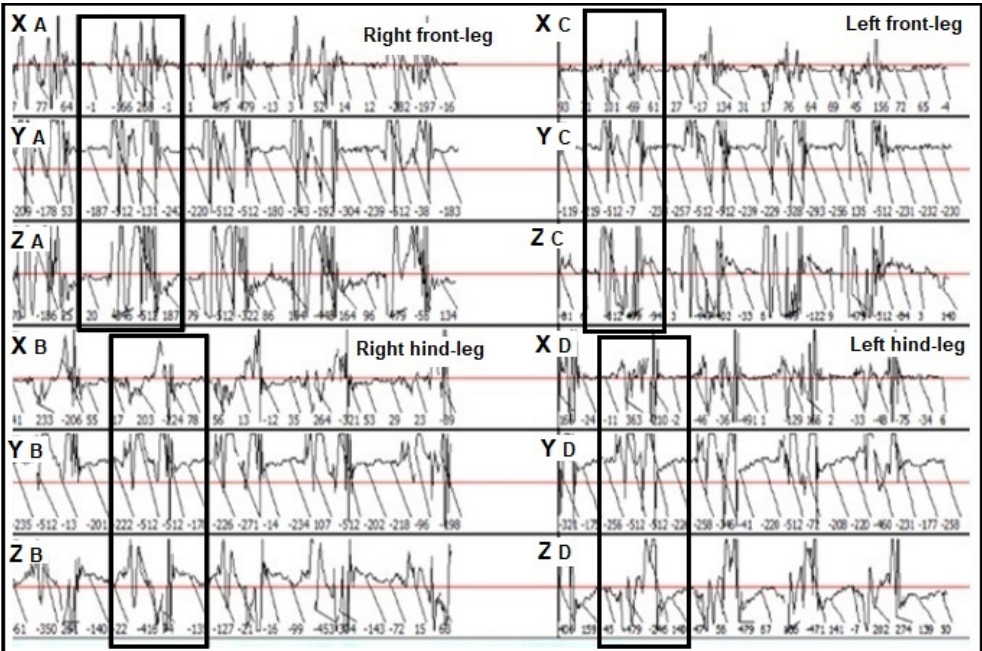
Figure 4. Step identification (rectangles) on the graphs constructed by the Lameness Detector 0.1 software. XA: protraction–retraction movement of the right front-leg recorded on the X axis; YA: upward–downward movement of the right front-leg recorded on the Y axis; ZA: abduction–adduction movement of the right front-leg recorded on the Z axis; XB: protraction–retraction movement of the right hind-leg recorded on the X axis; YB: upward–downward movement of the right hind-leg recorded on the Y axis; ZB: abduction–adduction movement of the right hind-leg recorded on the Z axis; XC: protraction–retraction movement of the left front-leg recorded on the X axis; YC: upward–downward movement of the left front-leg recorded on the Y axis; ZC: abduction–adduction movement of the left front-leg recorded on the Z axis; XD: protraction–retraction movement of the left hind-leg recorded on the X axis; YD: upward–downward movement of the left hind-leg recorded on the Y axis; ZD: abduction–adduction movement of the left hind-leg recorded on the Z axis.